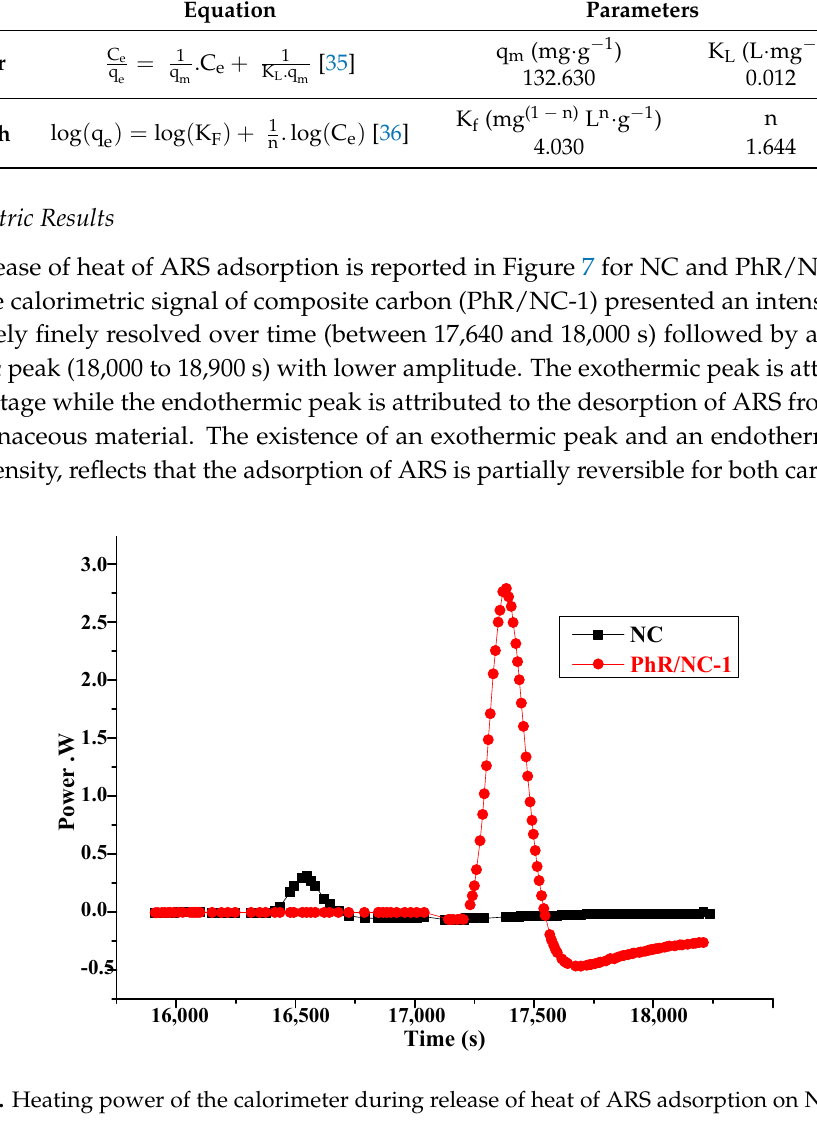
Table 4. Isotherm parameters of ARS adsorption.